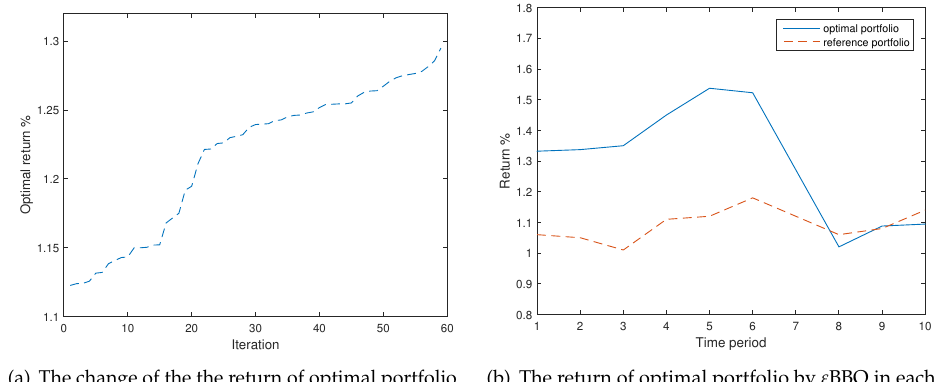
(b) The return of optimal portfolio by ε BBO in each period with benchmark portfolio Figure 4. The performance of the ε BBO and the optimal portfolio in X ∈ [ − 1,2 ] of model